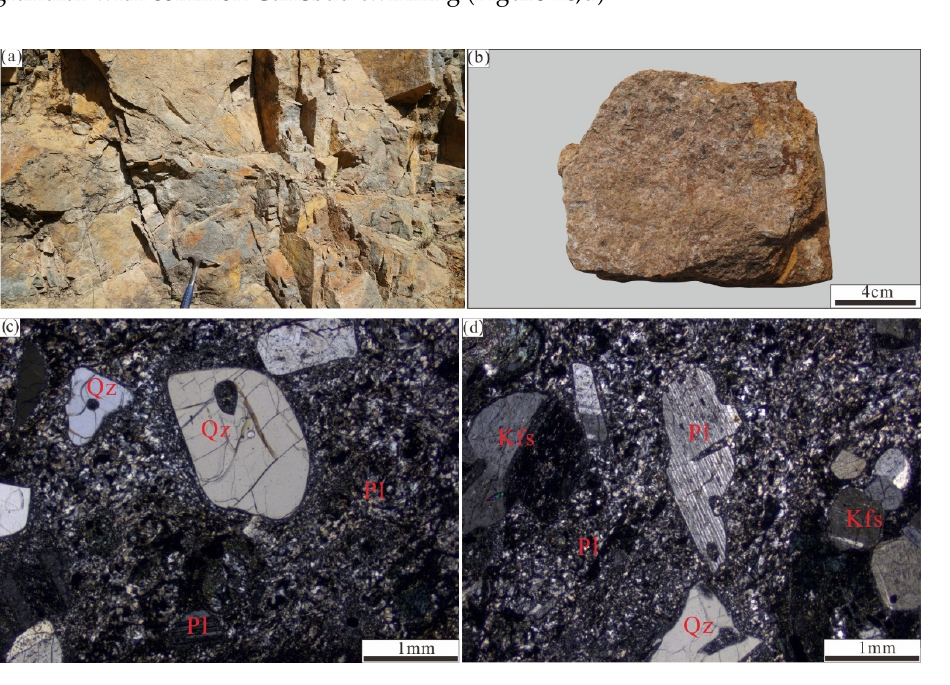
Figure 4. Photos/photomicrographs of the Madeng dacite: ( a ) porphyritic dacite outcrop; ( b ) dacite hand-specimen; ( c – d ) thin-section photomicrograph of dacite. Abbreviation: Qz—Quartz; Kfs—K- feldspar; Pl—Plagioclase. Table 1. Summary of samples from Madeng area.